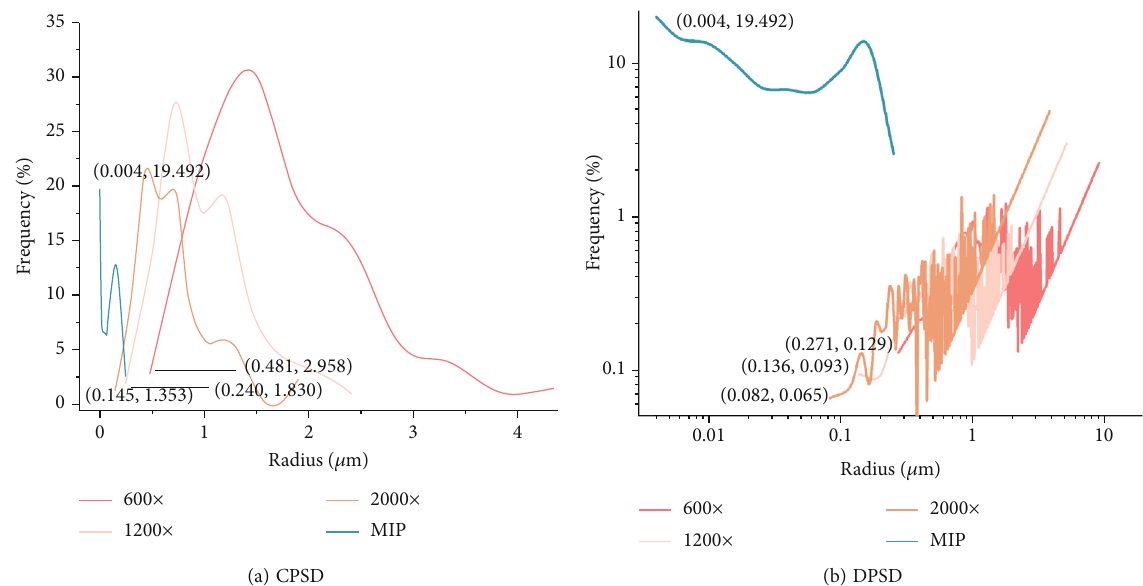
Figure 8: Calculation results of pore size distribution based on digital images and MIP.